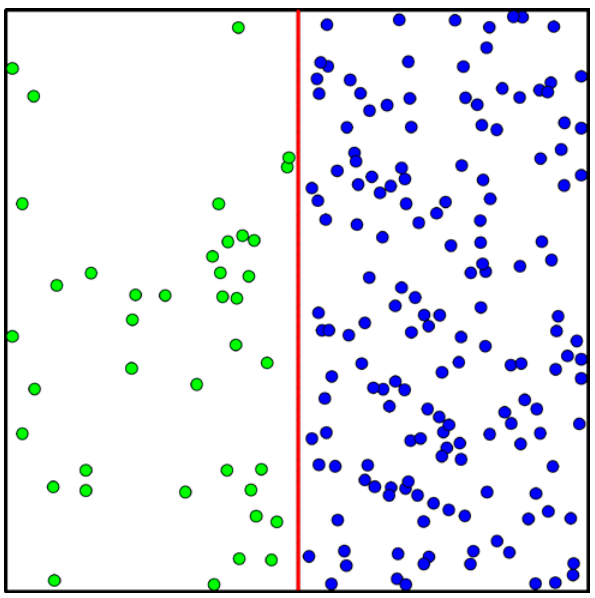
Figure 3. Initial configuration of a mixture of A (blue) and B (green) structureless equally sized (σ = 1.4 Å) particles in a 60x60 Å 2 simulation cell. The total number N of particles was 200 and the fraction of B particles was 0.2. At the beginning of the simulation, A and B particles are contained in two compartments separated by the impermeable barrier also